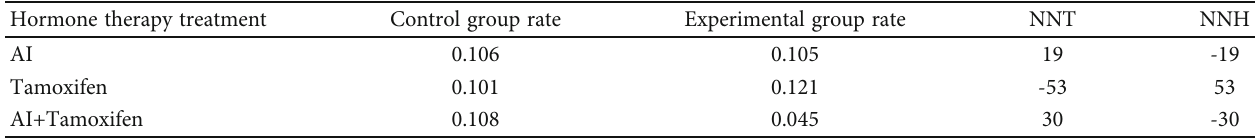
Table 14: Acceptance of hormone therapy treatments.